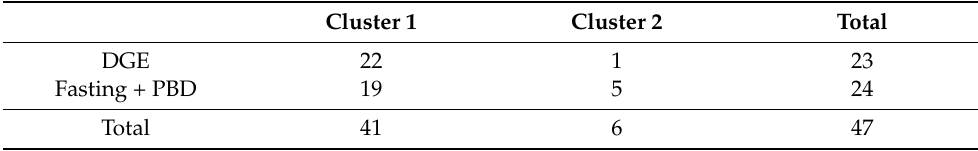
Table 5. Cluster analysis on baseline versus week